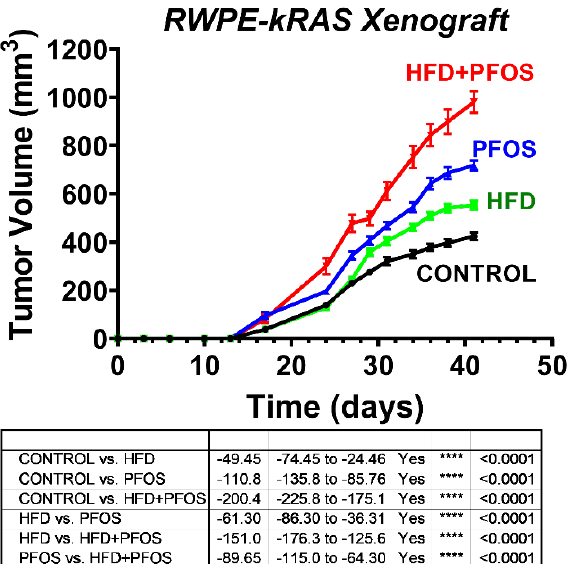
Figure 2. PFAS and an HFD synergize to increase prostate cancer xenograft growth. The 1 × 10 6 RWPE-kRAS cells were injected subcutaneously in 4-week-old athymic nude male mice. Mice were fed an HFD or control diet and treated with 10 mg/kg oral PFOS or vehicle control 5 days/week for 40 days. Tumor volume was measured using electronic calipers three times/week. A two-way ANOVA model for the time dependent effects of treatments on tumor growth was fitted. When the change is significant, Tukey’s multiple comparison test was employed.